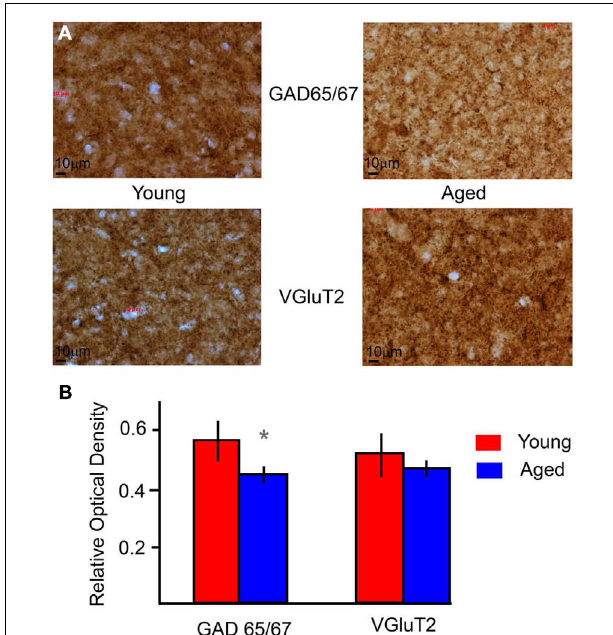
FIGURE 8 | Immuno-histochemical levels of GAD andVGluT2 in young and aged IC. (A) Example sections of the IC stained for GAD (top) and VGluT2 (bottom) for young (left) and aged (right) animals under 40× magnification.The dimensions of the sections are 208.2 × 156 µ m. (B) Average relative optical densities of GAD 65/67 andVGluT2 from the IC of young (red) and aged (blue) animals. ROD is marked along the Y -axis, and the type of marker along the X -axis. Error bars indicate one standard deviation. Asterisks indicate significant difference ( p < 0.01, unpaired t -test).